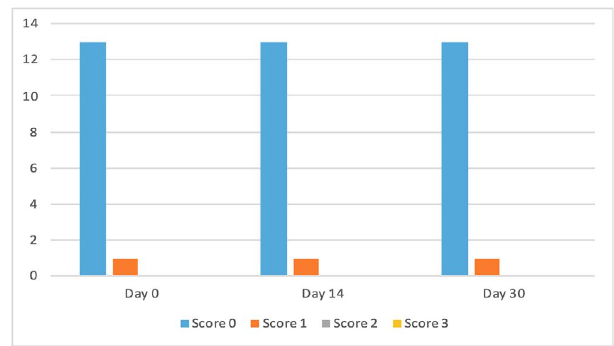
Figure 6. Number of cats according to the clinical score for scales in Group 1 (NexGard Combo (cid:1) ).